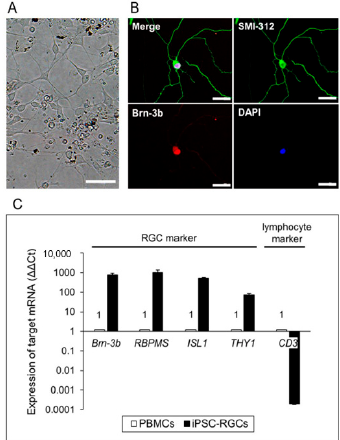
Figure 2. iPSC-derived RGCs (iPSC-RGCs) isolated from 3D retina using immunopanning. ( A ) The morphology of iPSC-RGCs at 3 days after isolation showed neurites with cell bodies (dendrite-like morphology). Scale bars, 50 µ m. ( B ) Expression of the RGC marker, Brn-3b (red), and neurofilament marker, SMI-312 (green), on iPSC-RGCs was confirmed with ICC. No staining was seen with isotype controls (mouse, goat, and rabbit IgG). Cell nuclei were counterstained with DAPI. Scale bars, 50 µ m. ( C ) Quantitative RT-PCR analysis of iPSC-RGCs. iPSC-RGCs (black bars) highly expressed mRNA for RGC-related genes ( Brn-3b , ISL1 , RBPMS , and THY1 ), whereas RGCs poorly expressed the lymphocyte marker, CD3 . We used PBMCs (from the same TLHD2 donor: open bars) as control cells. Results show the relative expression ( ∆∆ Ct: control cells = 1) and represent the mean ± standard deviation (SD) ( n =